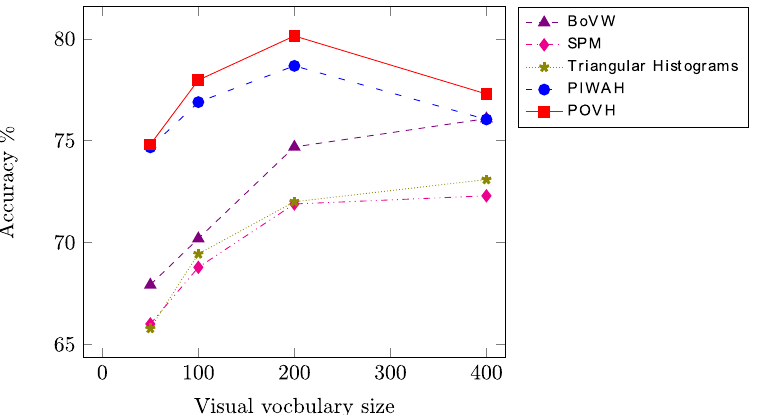
Fig 8. Representation of classification accuracy obtained when using vocabulary of different sizes for SIRI-WHU